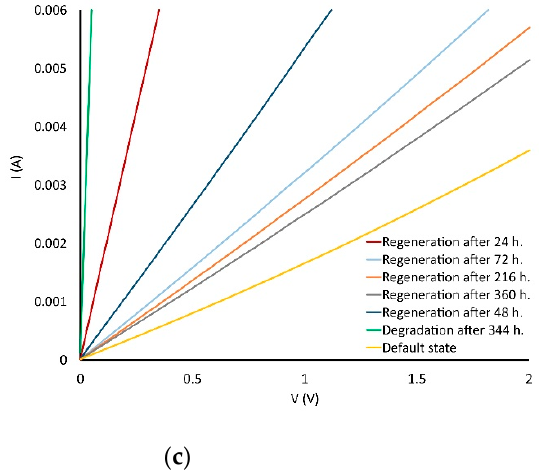
Figure 9. ( a ) I-V curves during regeneration for PV module. ( b ) Cole-Cole curve during regeneration for PV module. ( c ) Dark I-V curve during regeneration for PV module.